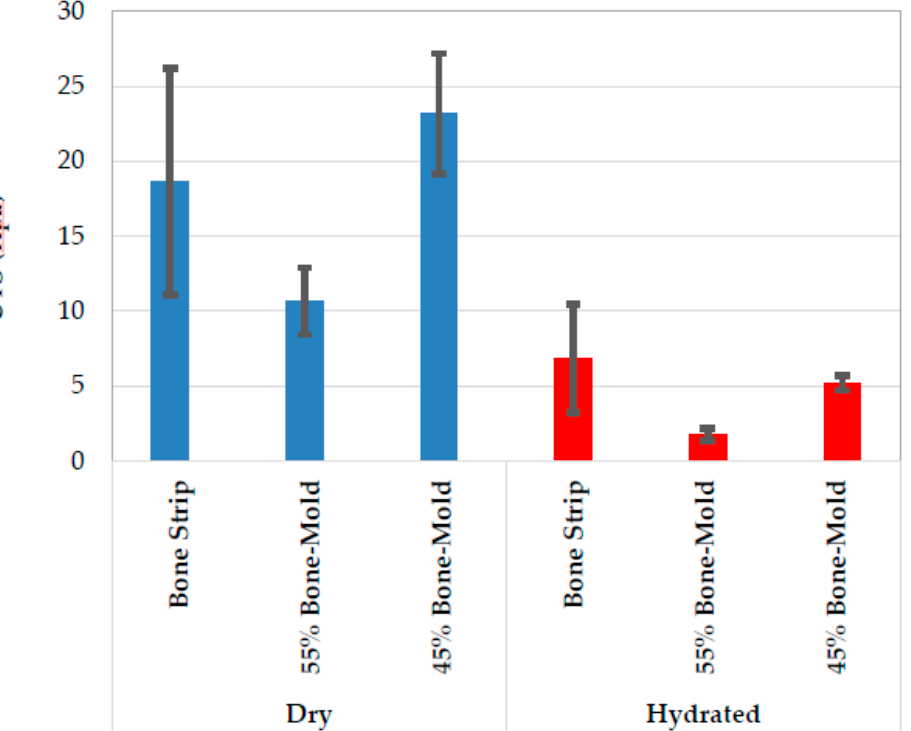
Figure 8. Summary of the hydration impact on ultimate tensile strength.